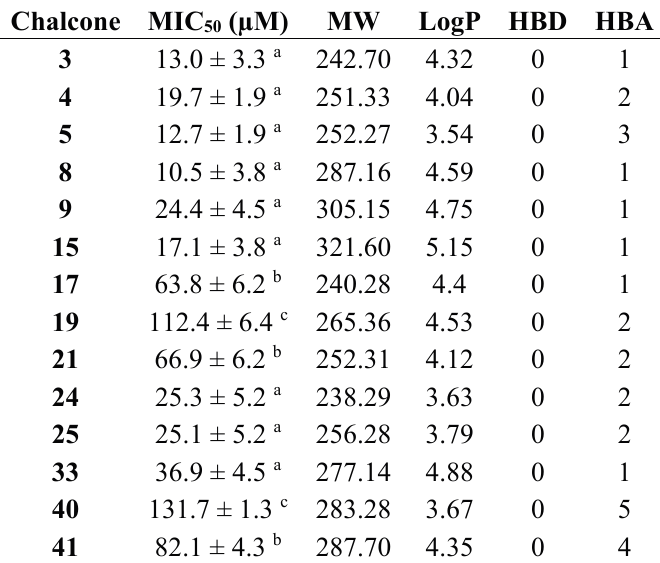
Table 5. Lipinski’s “rules of five” analysis parameters of biologically active chalcone